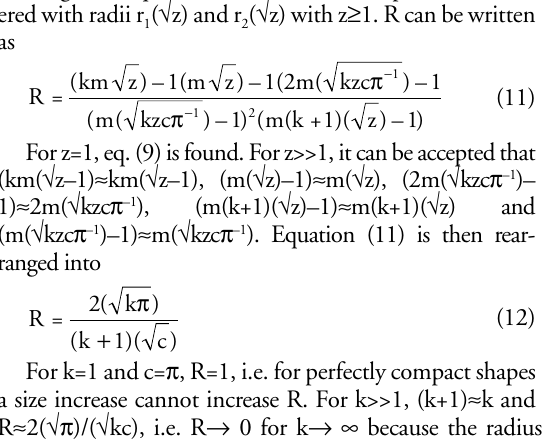
Fig. 5. Effect of disturbance penetration depth d and size ratio z on R for elliptical shapes (k=3). To calculate the actual patch size, z is multiplied by 500(z<1 ≥ a<500; z=1 ≥ a=500; z>1 ≥ a>500). For z>>1, R ≈ 2( √ 3)/4 ≈